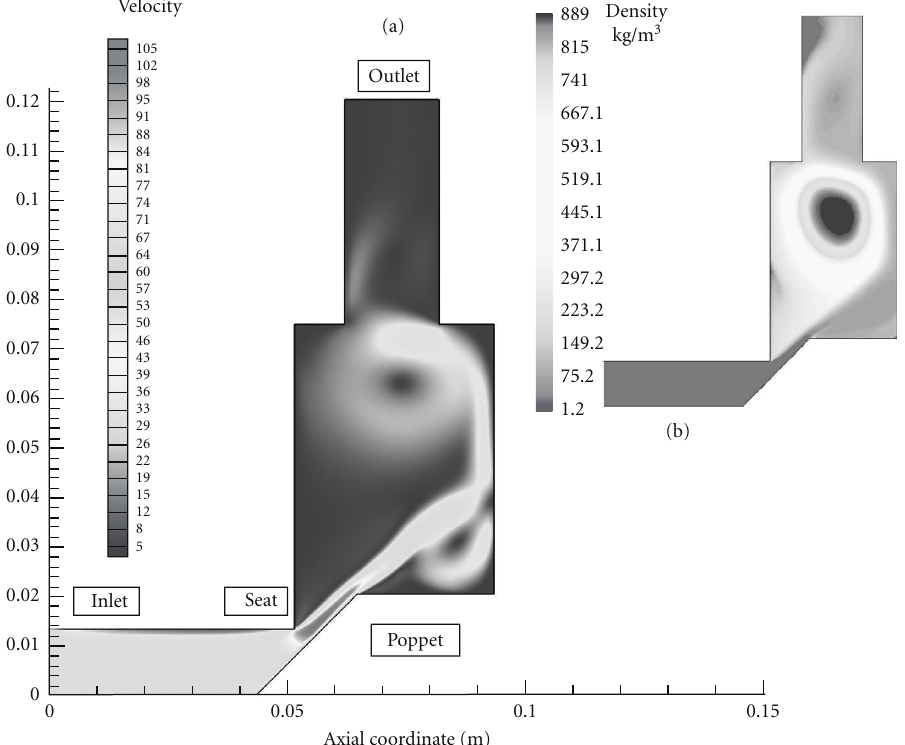
Figure 12: Velocity field and corresponding liquid-vapor mixture density distribution for cavitating